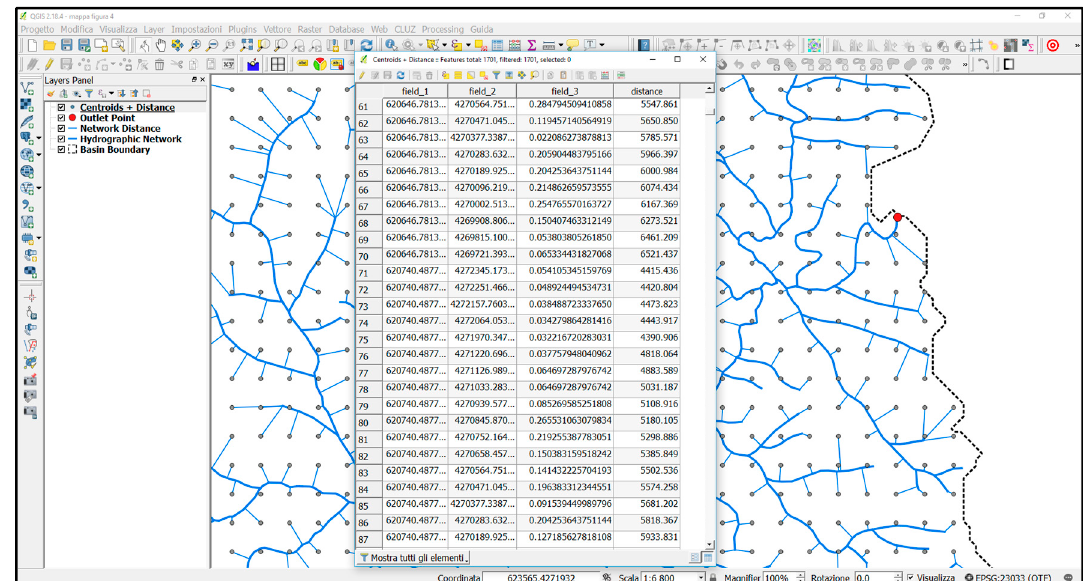
Figure 4. The new centroid layer integrated by the “distance” information.